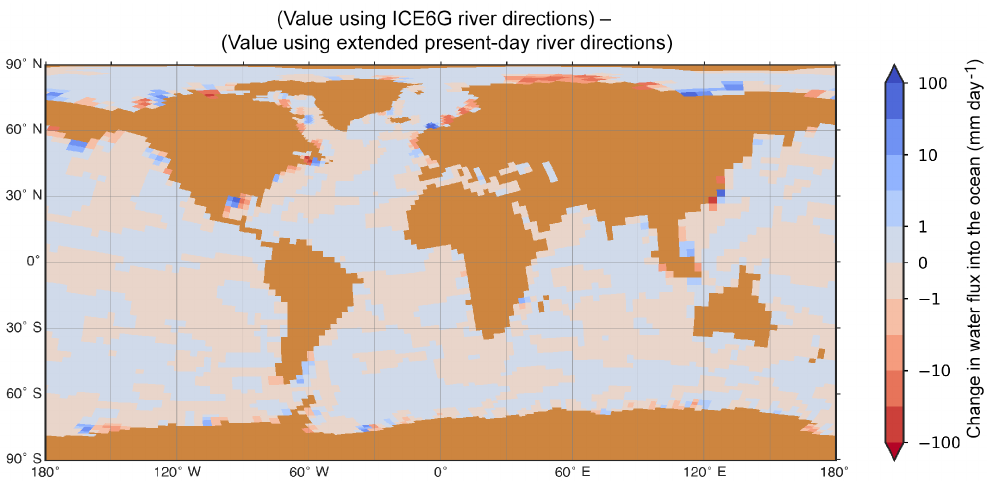
Figure 8. Changes in the freshwater flux into the ocean between simulations run in the MPI-ESM model of the LGM using extended present- day river directions and using dynamic river directions. The changes are defined such that an increase in the version using dynamic river directions is positive. A symmetrical logarithmic colour scale is used: above 1, the colour scale is logarithmic; between 1 and − 1, the colour scale is linear; below − 1, the colour scales according to the negation of the logarithm of the change’s